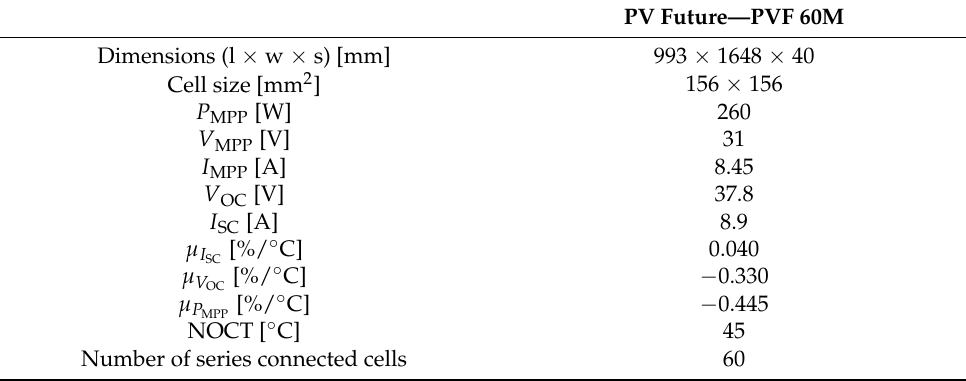
Table 2 for the considered mono-crystalline PV module for STC (PV Future—PVF 60M) [40]. Table 2. Electrical parameters of the considered mono-crystalline PV module for